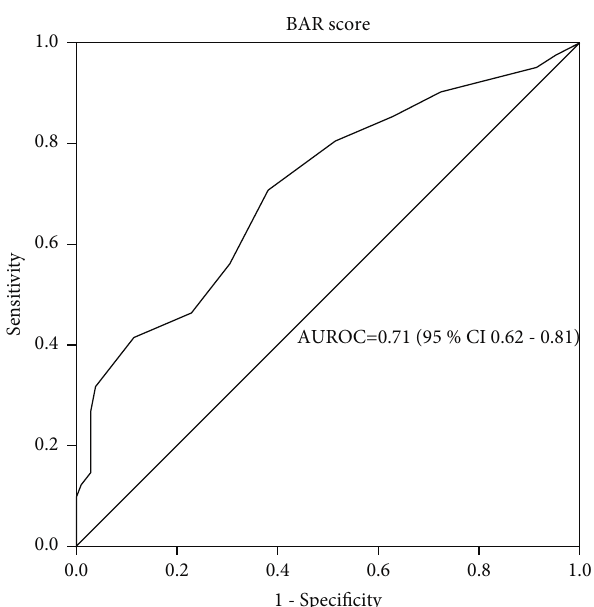
Figure 3: Receiver operating characteristic curve for the BAR score in predicting post-transplant 5-year survival. BAR, balance of risk; AUROC, area under the receiver operating characteristic curve.